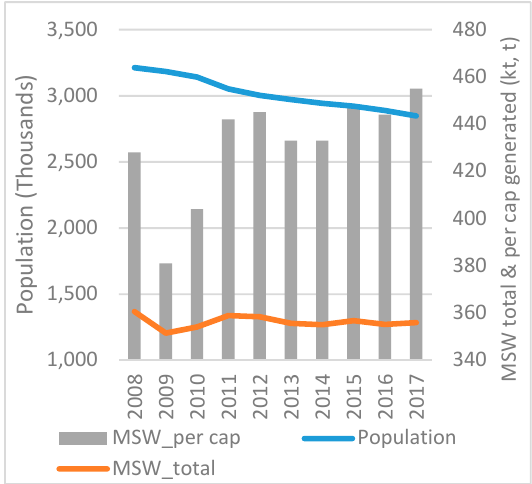
Figure 29. Population and MSW production in Lithuania 2008–2017 (EUROSTAT 2019a, 2019c).